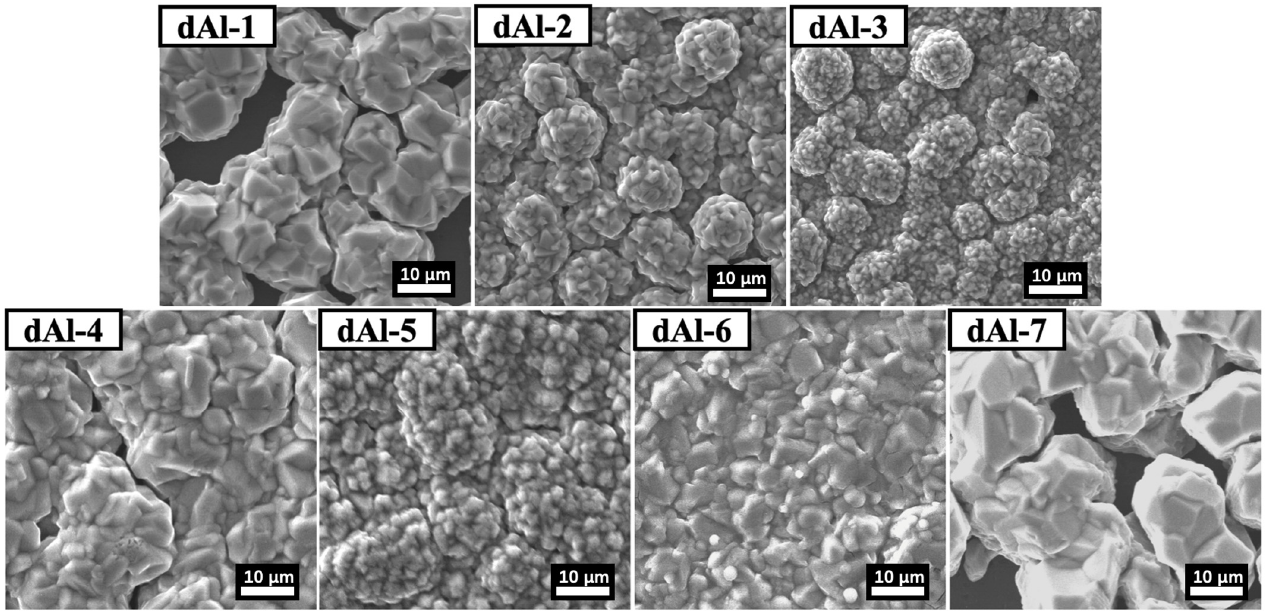
Figure 2. Surface morphologies of Al coatings on B 4 C from EMIC–AlCl 3 ionic liquid under the different pre-treatments.